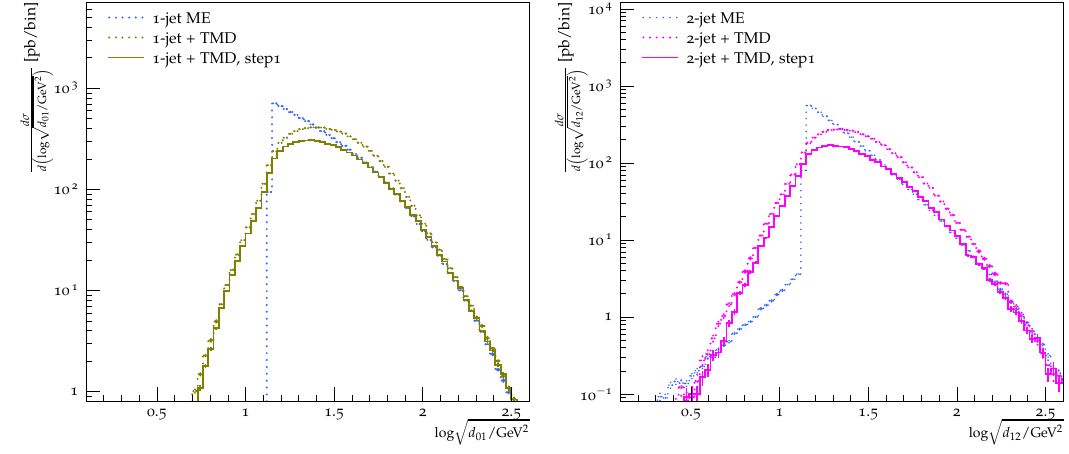
Figure 4 . The d n,n +1 spectra for n = 0 (left) and n = 1 (right) at parton level, where d n,n +1 represents the energy-square scale at which an ( n + 1) -jet event is resolved as an n -jet event in the k jet-clustering algorithm. The dotted blue curve represents the ME level of the Z + 1 (left) and ⊥ Z + 2 (right) jet calculations. The dotted green and magenta curves represent the Z + 1 and Z + 2 jet ME computations respectively, after the PB-TMD evolution is applied. The solid green and magenta curves represent the Z + 1 and Z + 2 jet computations respectively, after step1 of the TMD merging method is applied, where step1 corresponds to the items 1, 2, 3 and 4 of the procedure in subsection